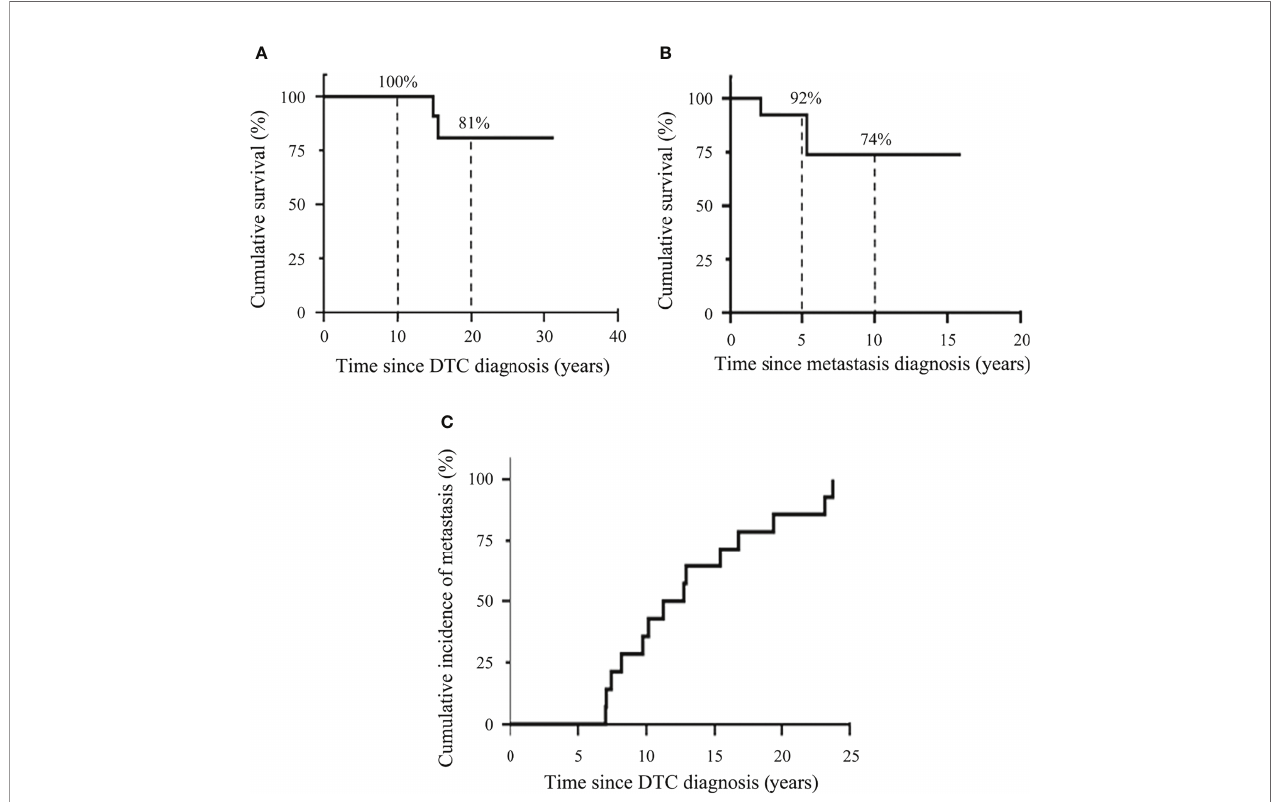
FIGURE 2 | Kaplan – Meier plots demonstrating disease-speci fi c survival of DTC patients and cumulative incidence of distant metastasis. (A) Kaplan – Meier plots for survival after the diagnosis of DTC. (B) Kaplan – Meier plots for survival after the diagnosis of distant metastasis. (C) Cumulative incidence of distant